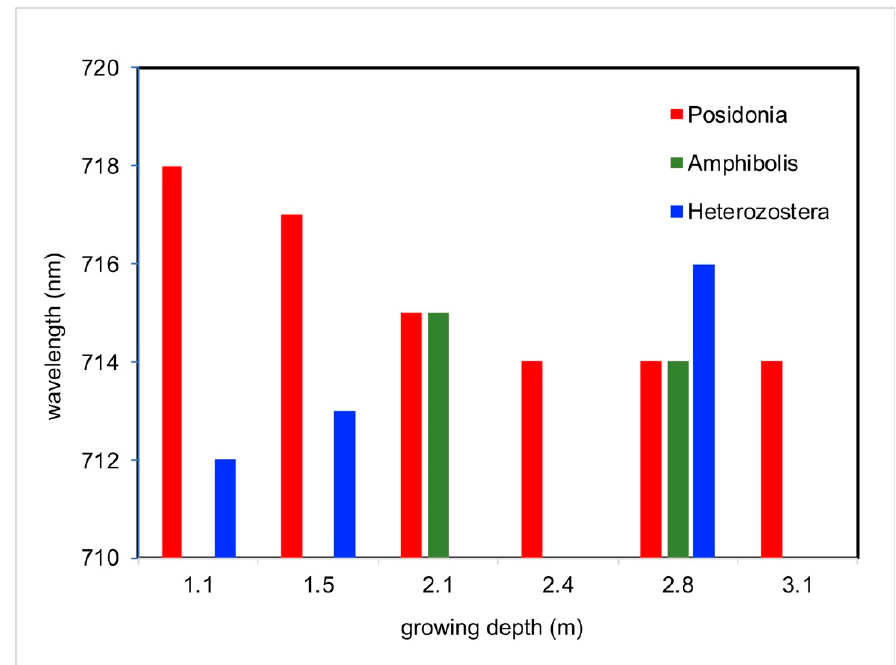
Figure 9. Position of “700 peak” with varying depths for Posidonia , Amphibolis , and Heterozostera .